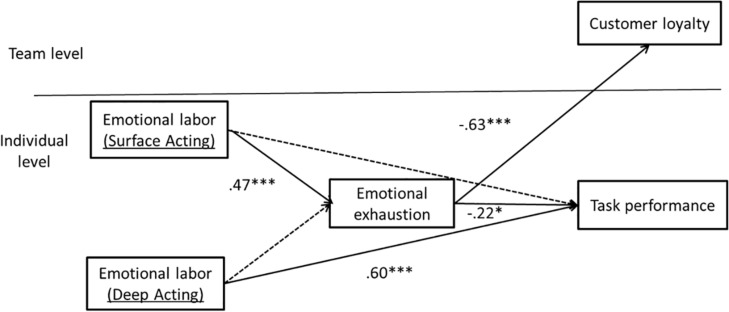
Two-level path analysis resultsa. N = 229, R2 emotional exhaustion = 0.28. R2 task performance = 0.37. R2 customer loyalty = 0.55. Standardized coefficients are presented. a: Control variables are not presented. —-> means that there is significant relationship between them *p < 0.05, ***p < 0.001.